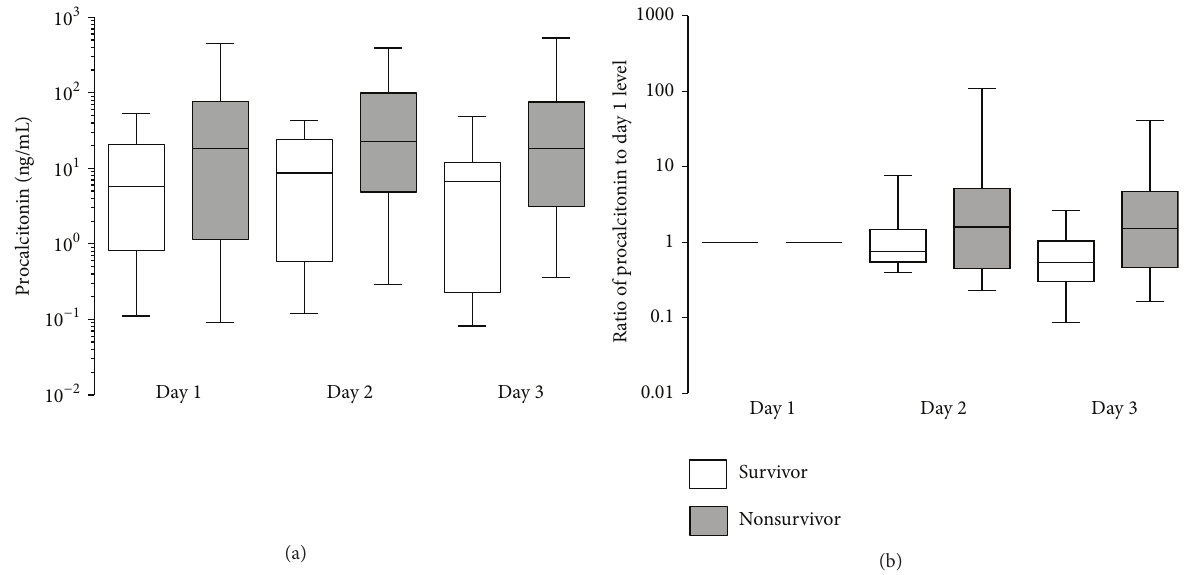
Figure 2: Temporal profiles of PCT in severe sepsis cohort between suvivors and nonsurvivors. (a) PCT concentration, Repeated Measures ANOVA (𝑃 = 0.012) . (b) Ratio of PCT relative to Day 1.